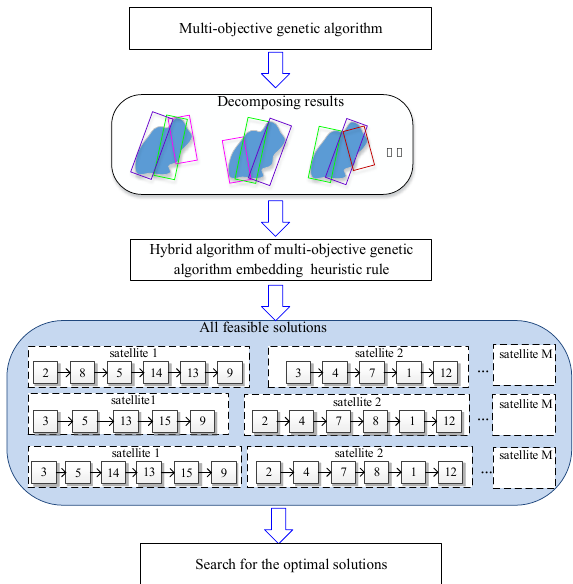
Figure 1. The flowchart of solving